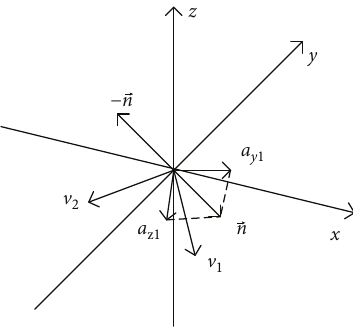
Figure 3: Schematic diagram of command